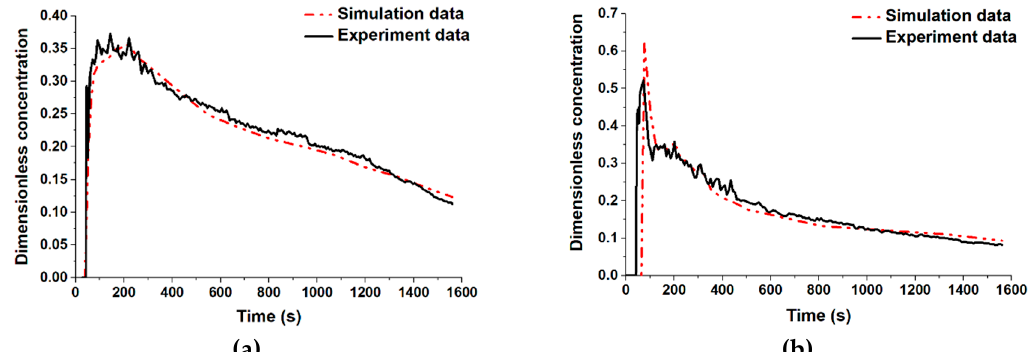
Figure 4. Comparison between the residence time distribution (RTD) curves for the experiment and the simulation. ( a ) Strand #2 and ( b ) Strand #4.